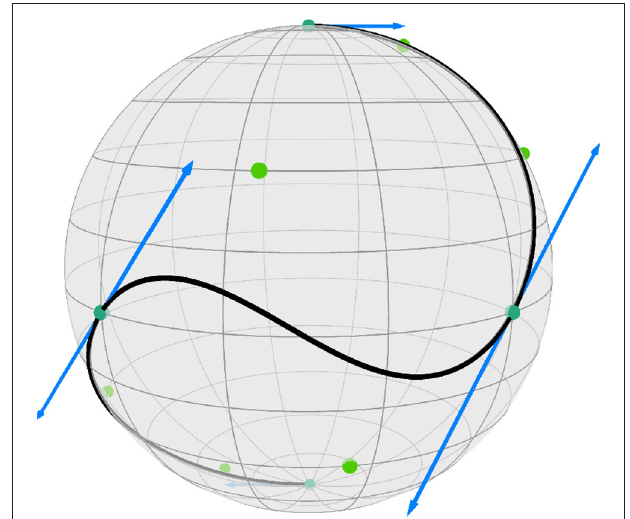
FIGURE 2 | Construction of a cubic Bézier curve via the De Casteljau algorithm.